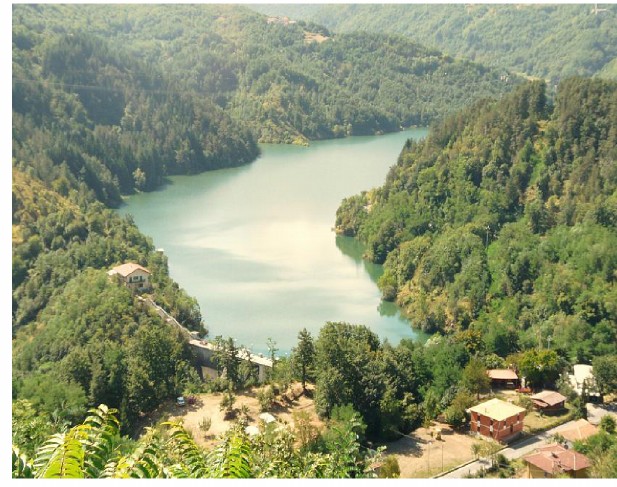
Figure 3. Pontecosi